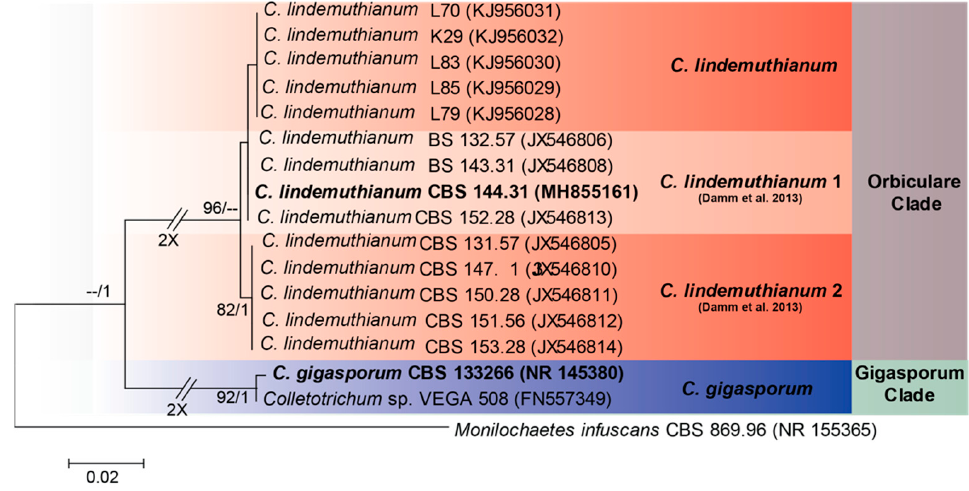
Figure 4. An ML tree of the orbiculare and gigasporum clades that includes species reported in northern South America (Colombia, Ecuador, Peru, and Venezuela). The tree was created based on the alignment of ITS (436 bp). The GenBank accession numbers of sequences retrieved from the database are given in parentheses. Reference strains are presented in bold. Branch lengths are proportional to phylogenetic distance. The best substitution model for ML was determined to be T92+G. Bootstrap support values/Bayesian posterior probability scores above 70%/0.95 are indicated on the nodes. Clades 1 and 2 of C. lindemuthianum were reported by Damm et al. [19]. The tree was rooted to Monilochaetes infuscans CBS 869.96. T = Ex-type strain.